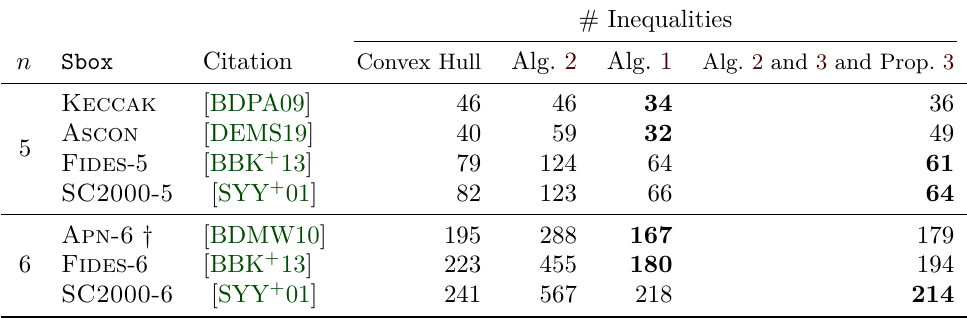
Table 5: Number of inequalities for modeling various 5 and 6-bit Sboxes with four different